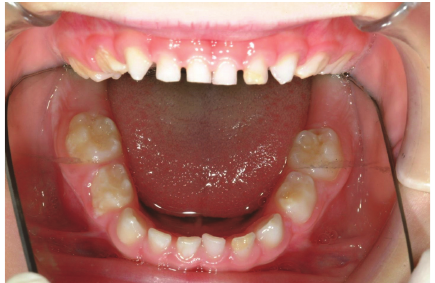
Figure 1: Broken down 55 to subgingival level and hypomineraliza- tion and hypoplasia of 54 and 64.